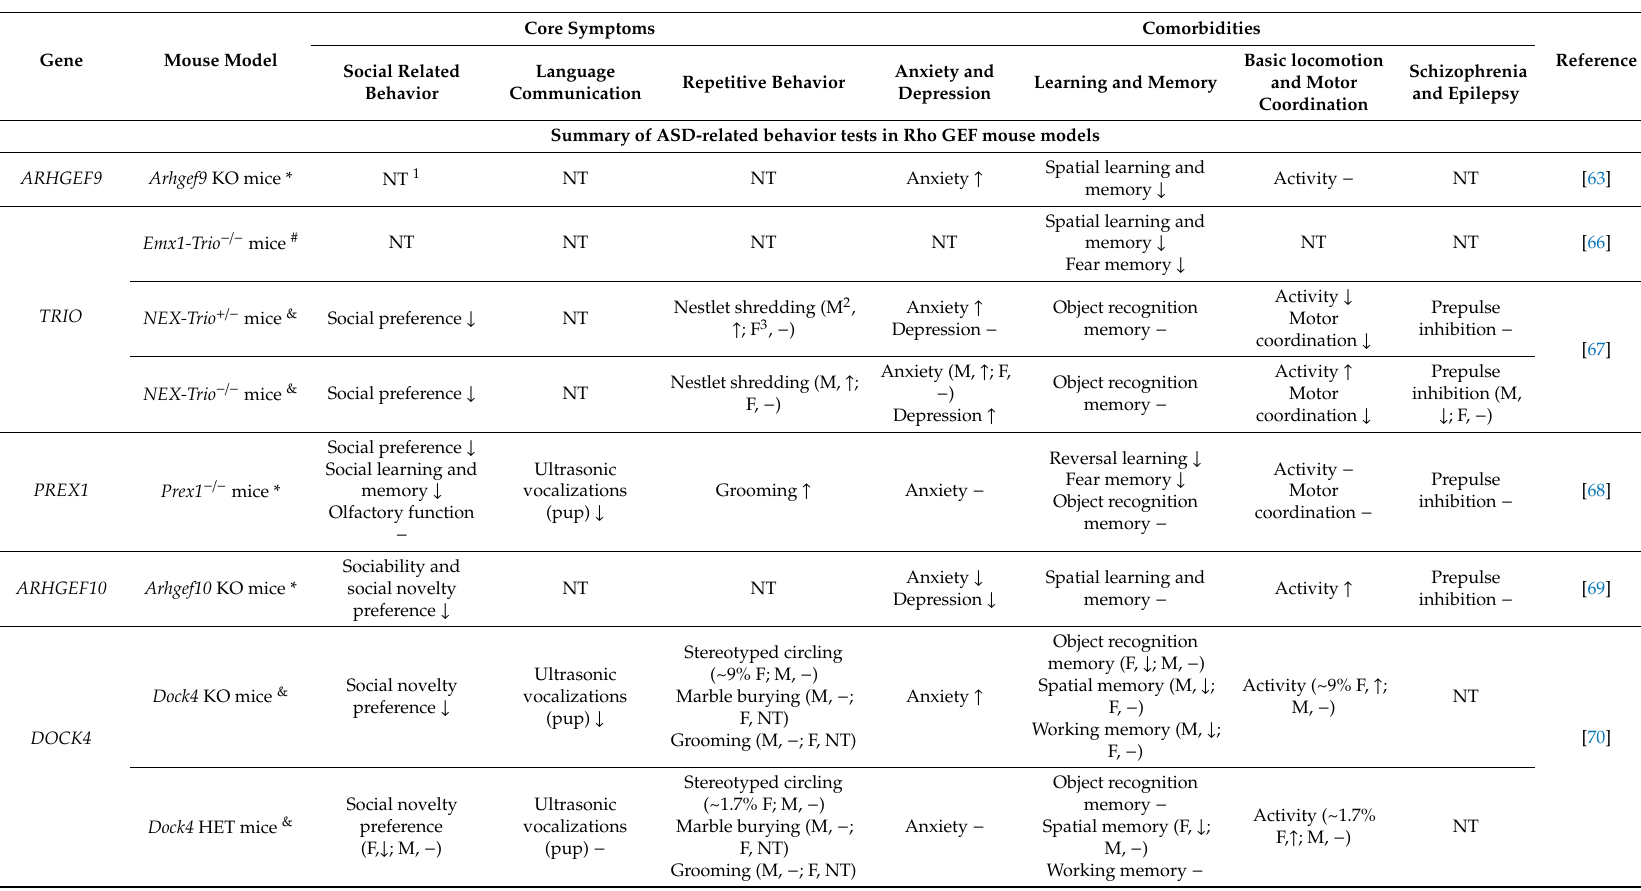
Table 2. Summary of ASD-related behavior tests in Rho guanine nucleotide exchange factor (GEF), GTPase-activating protein (GAP), and e ff ector mouse